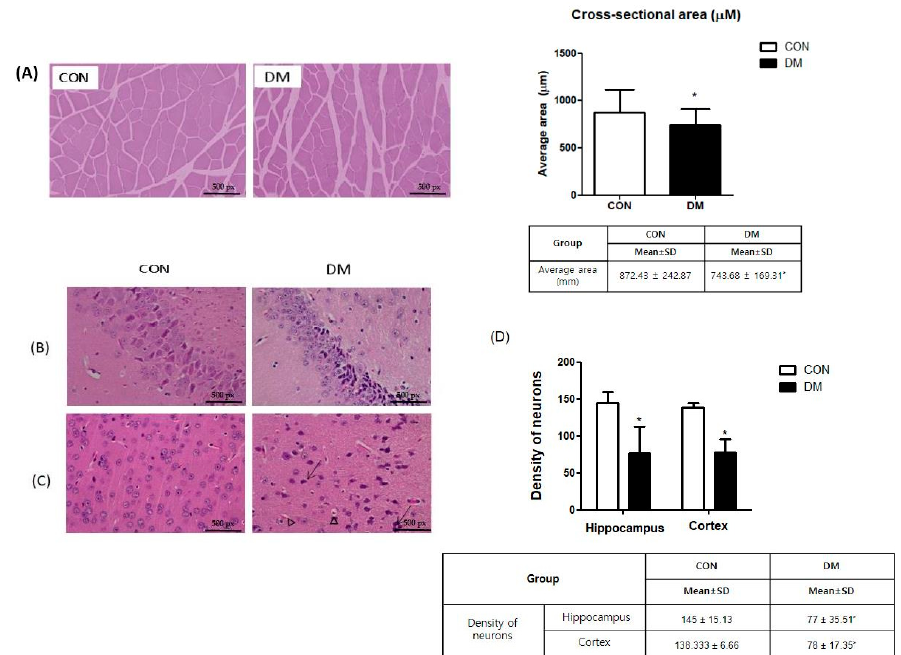
Figure 5. Morphological changes of ( A ) skeletal muscle and brain and ( B ) CA3, ( C ) cortex, and ( D ) density of neurons in hippocampus and cortex in T2DM mice (magnification ×200, scale bar = 500 px) Representative photos of skeletal muscle and brain section. Arrows indicate karyopyknosis of cells. Triangles indicate acidophilic necrosis. All values are reported as mean and SD. The asterisk represents statistical significance of differences from * p < 0.05. n = 9 mice in each group. CON, normal control mice; DM, diabetes mellitus mice.